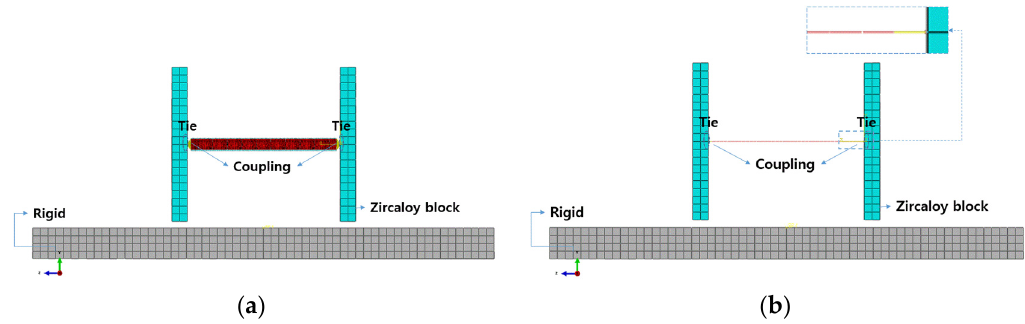
Figure 12. Finite element model for the dynamic analysis: ( a ) detailed model; ( b) simplified model.